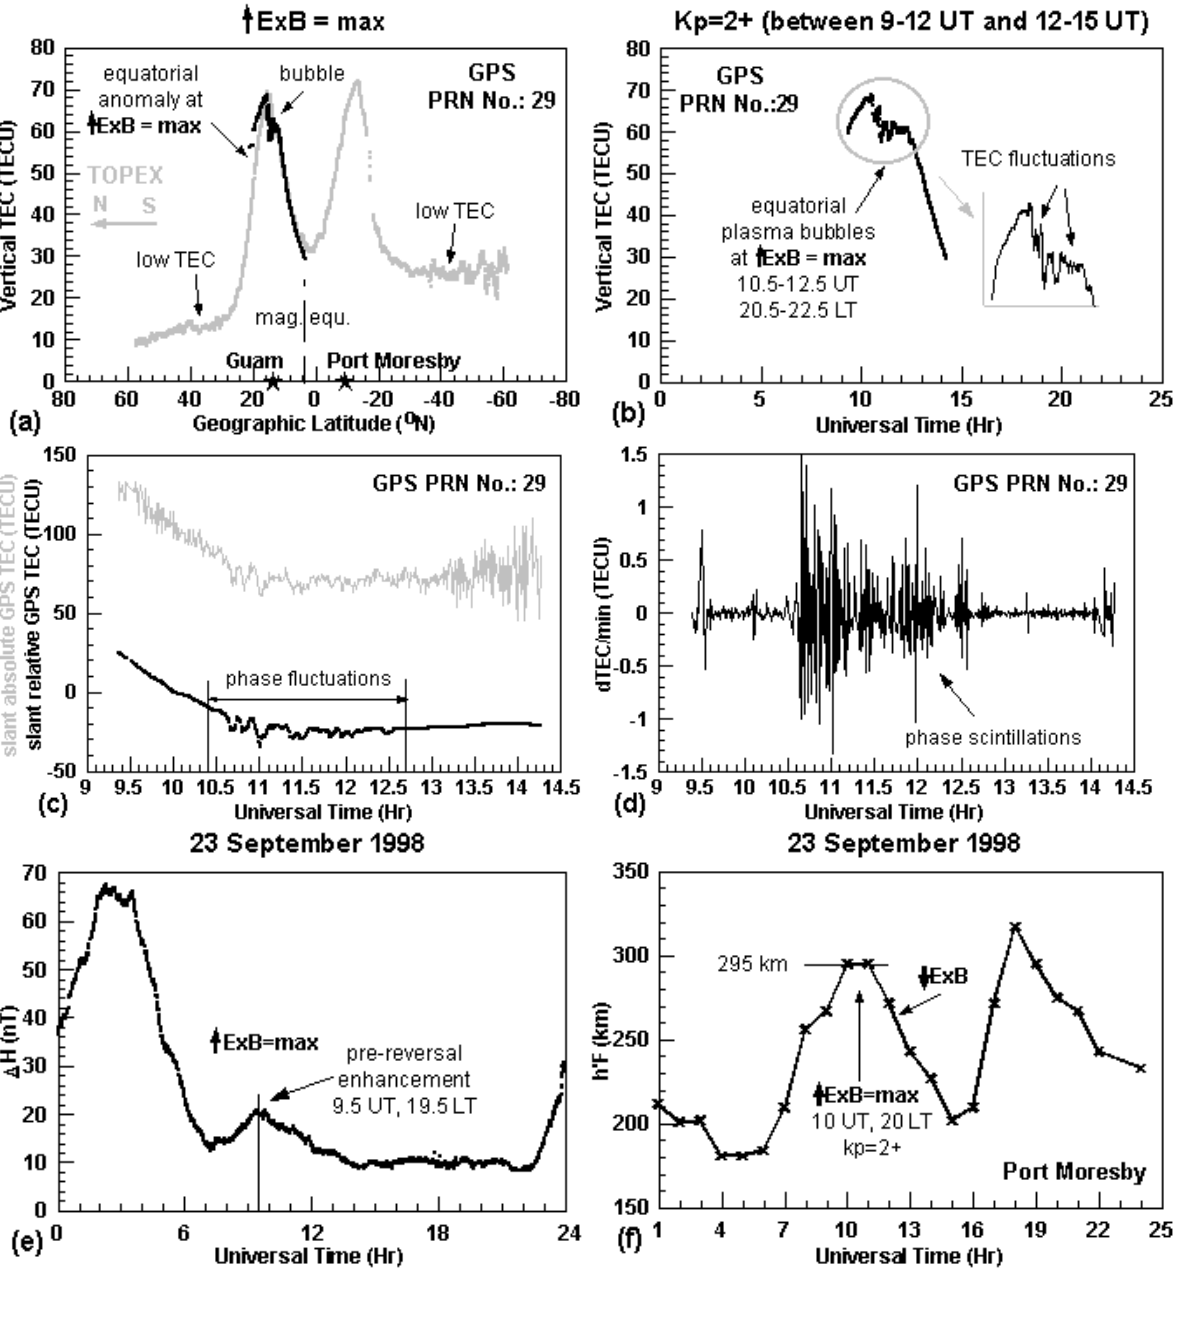
Fig. 4. The Guam GPS data show equatorial plasma bubbles (a) with the matching field-aligned TOPEX TEC curve (at 180 ◦ E, LT = 19:50 at the magnetic equator), which shows a mid-latitude low TEC region as well, in latitudes and (b) in time. (c) Signal degradation on the raw GPS TEC data is due to the GPS phase scintillation. (d) The filtered dTEC/min plot shows the intensity of that phase scintillation. (e) The 1 H data plot obtained with the Muntinlupa and Lumping magnetic data shows the time of pre-reversal strengthening at 121 ◦ E geographic longitude, in the Australian region. (f) The data from Port Moresby show the sudden increase in height due to the pre-reversal strengthening, and then the sudden decrease due to the reversal and downward